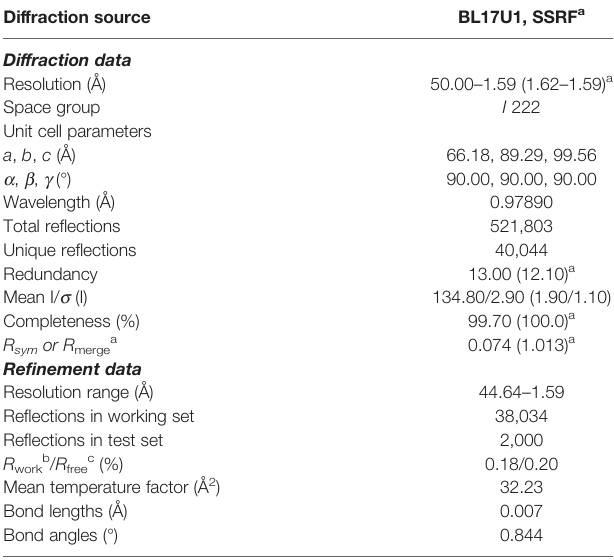
TABLE 2 | Data processing and re fi nement for complex crystal of Hsp90 N -NVP- AUY922. Diffraction